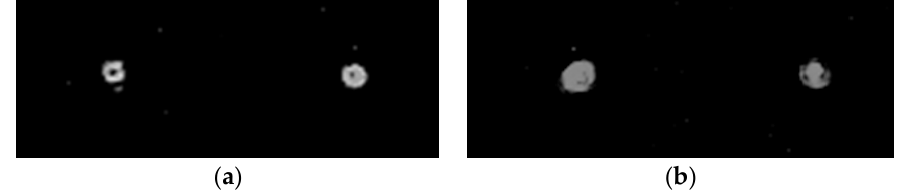
Figure 11. Intensity distributions in the focal plane of lens L2: ( a ) linearly polarized beam, and ( b ) azimuthally polarized beam.